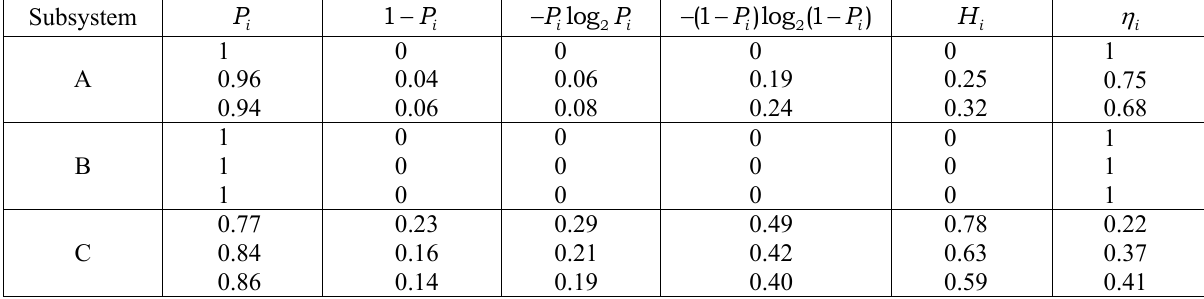
Table 2. Calculation of the values of stability of technology subsystems and the levels of its integrity